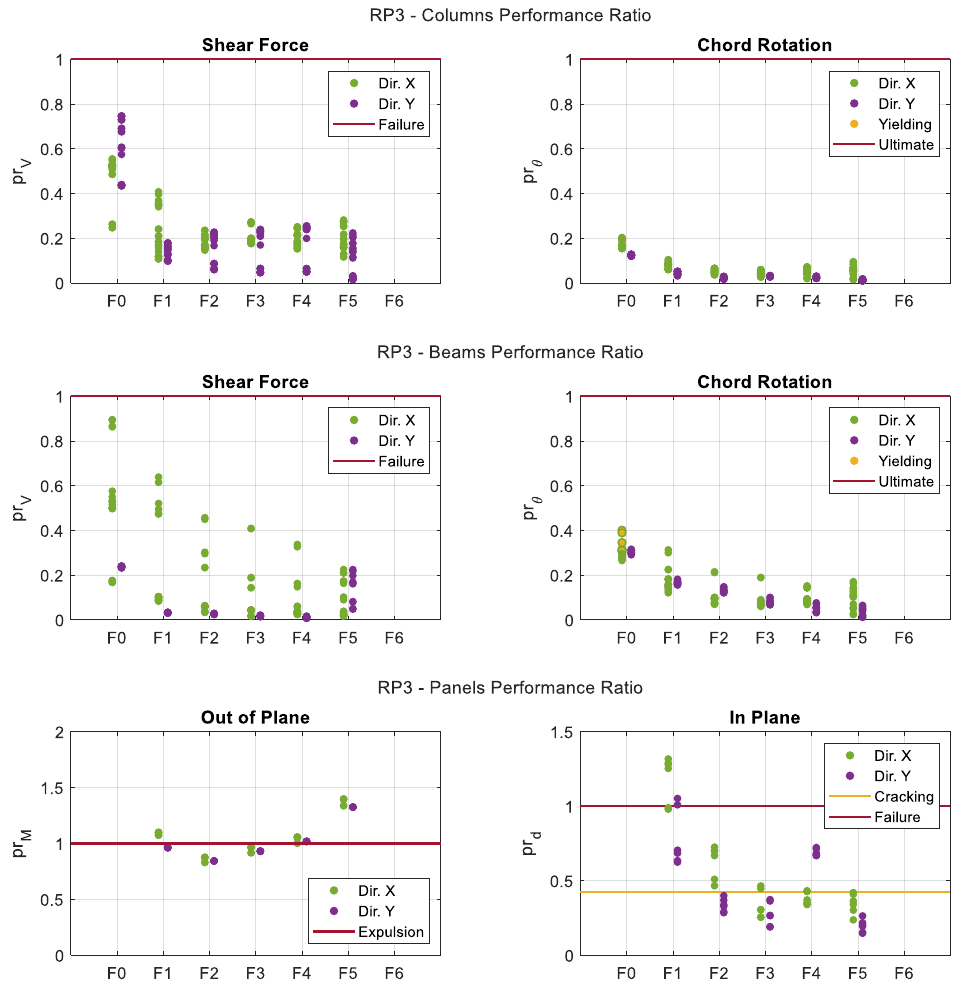
Figure 20. RP3 RC elements and infill panels performance ratios.